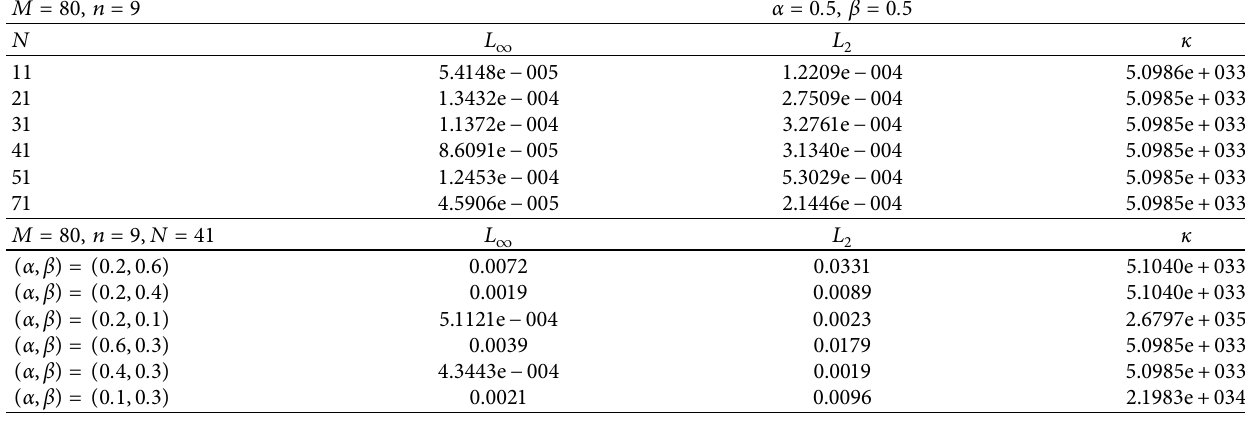
Table 2: Numerical results using the proposed numerical scheme corresponding to Problem 2.